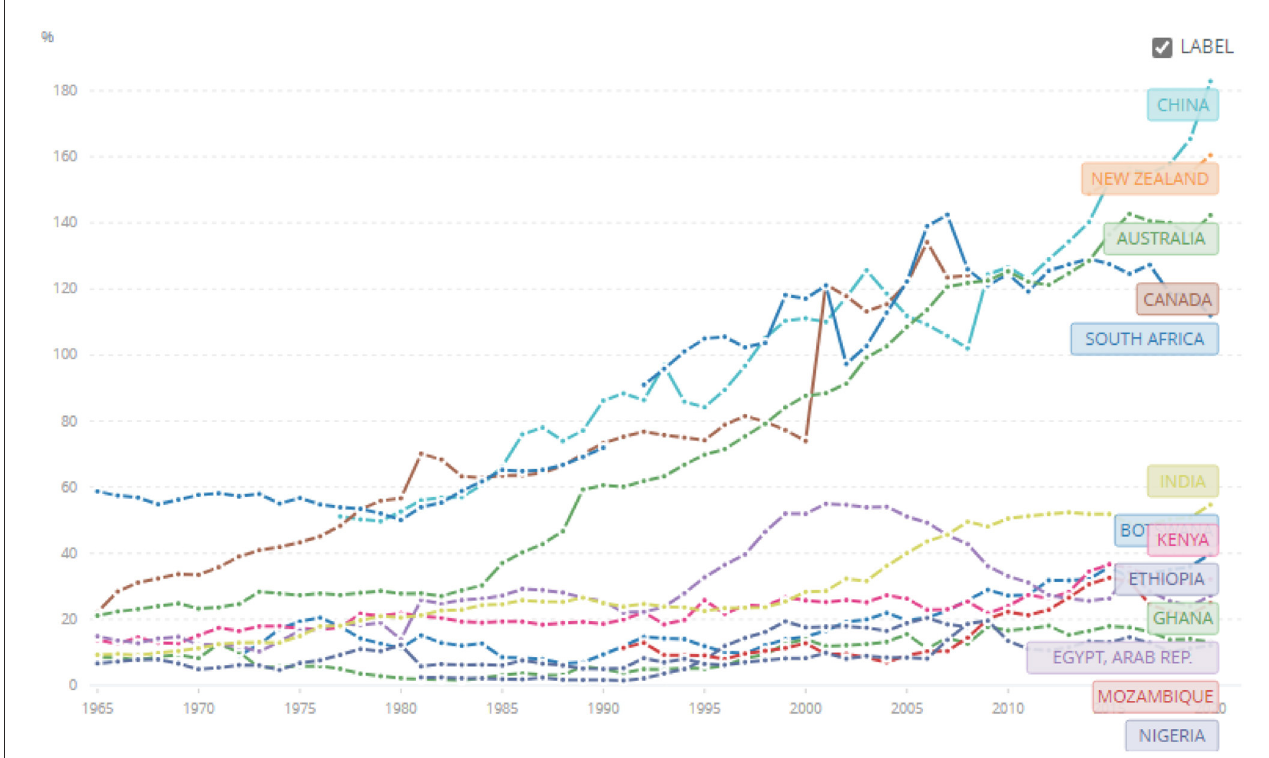
FIGURE5 Domestic credit to the private sector (% of GDP) from 1965 to 2020 for Australia, Botswana, Ghana, Ethiopia, Kenya, China, Egypt, India, Mozambique, Nigeria, Canada, New Zealand, and South Africa. Source: World Bank Data: https://data.worldbank.org/indicator/FS.AST.PRVT.GD.ZS?end=2020&